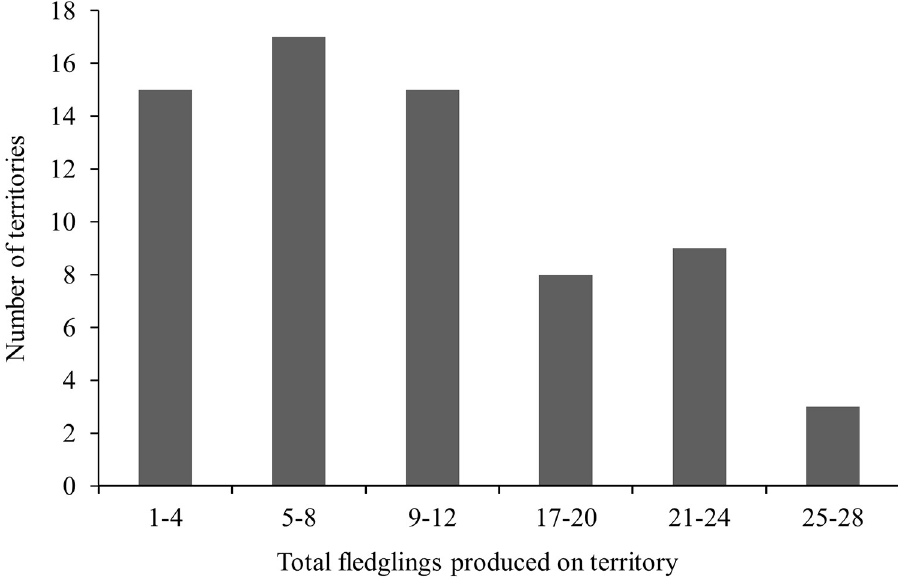
Fig 15. Total fledglings produced by goshawks on 79 territories monitored at least 18 years in Arizona, USA.